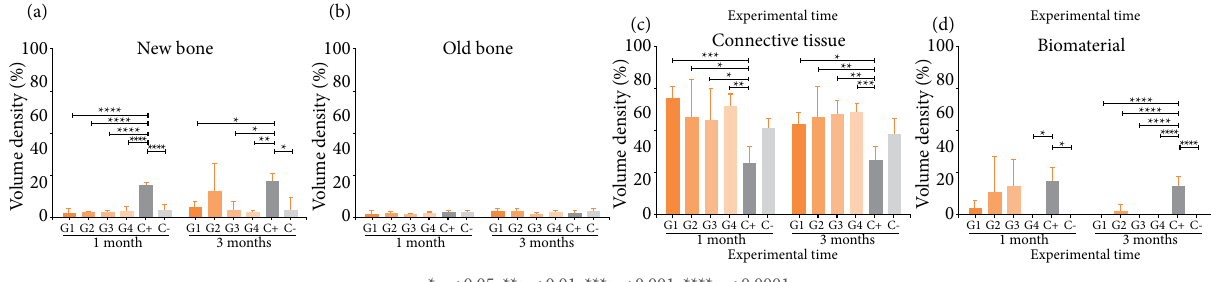
Figure 8 - Percentage of new and old bone, connective tissue, and biomaterial of poultry collagen- based hydrogels in critical size bone defect in rat calvaria at one and three